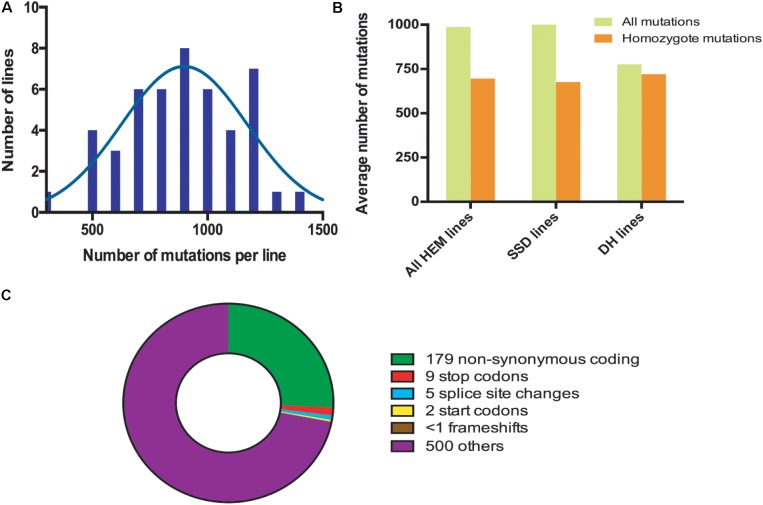
(A) Distribution frequencies of the total number of mutations per HEM line. (B) The average total number of and homozygous mutations per line, comparing the HEM lines and each of the subsets (SSDs and DHs). (C) Average number of each type of mutation predicted to change the sequence and/or knockout a protein in one HEM line. “Others” category includes: synonymous coding, intergenic, intragenic, intron, and synonymous stop mutations.